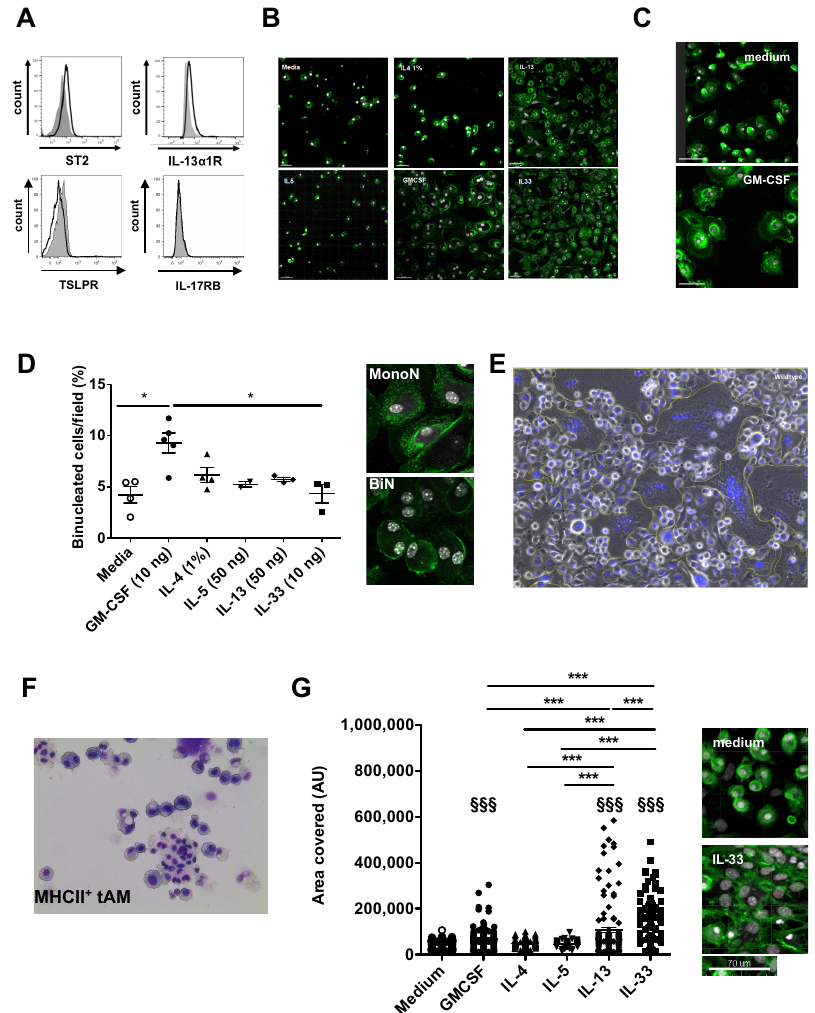
Figure 3. Tissue resident macrophages undergo binucleation upon GM-CSF treatment in vitro. ( A ) Resident tAMs express a receptor for IL-33 (ST2) and IL-13 (IL-13Ra), but not for IL-25